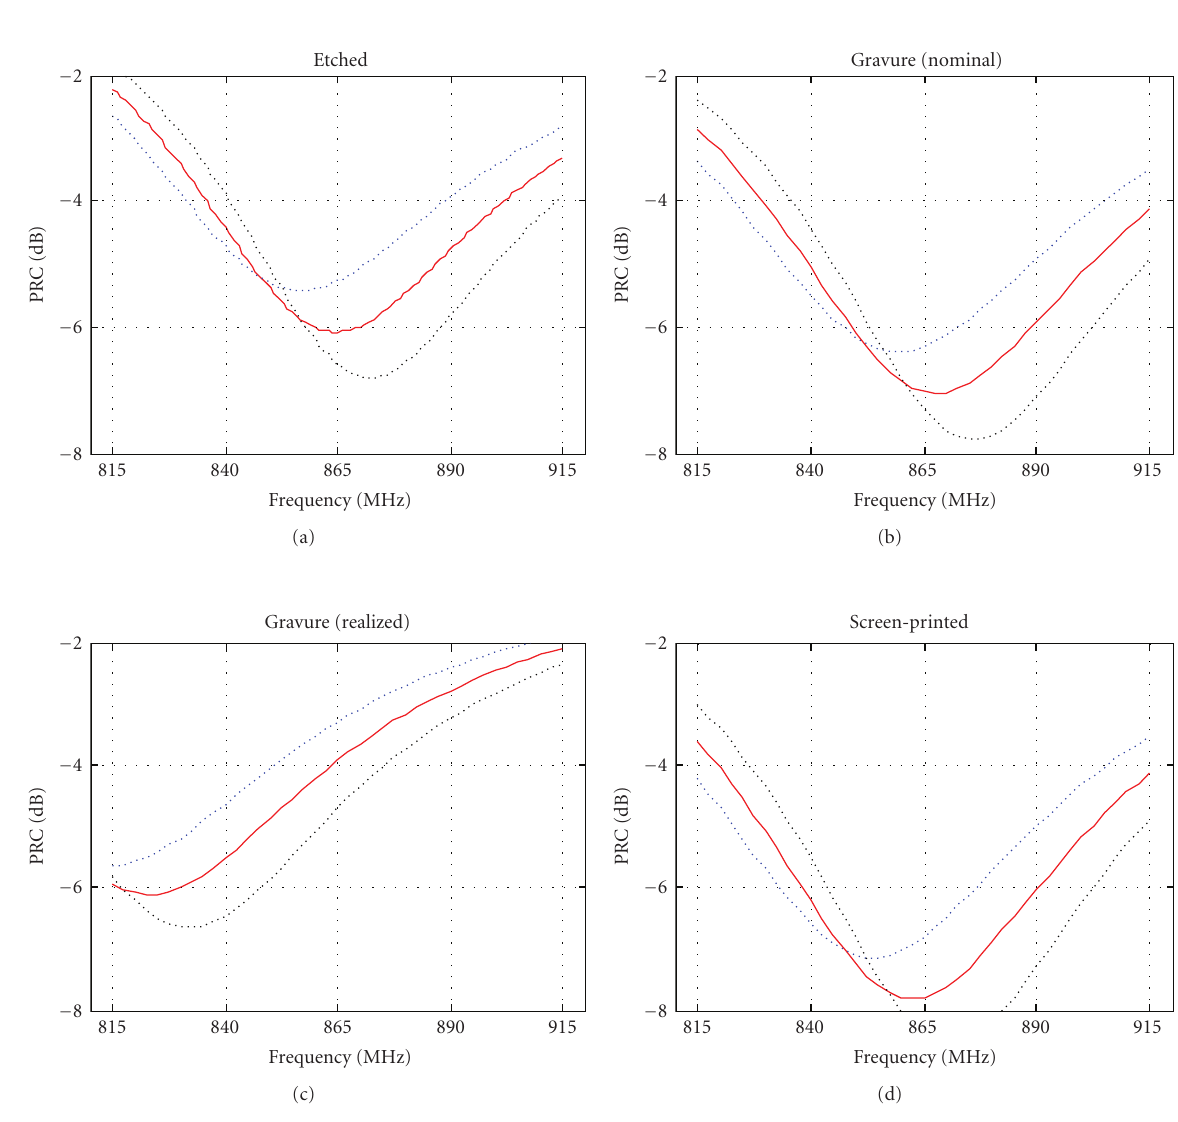
Figure 6: Calculated PRC’s according to simulated antenna impedances with − 3 Ω (red dashed curve) and +3 Ω (black dashed curve) tolerances for chip